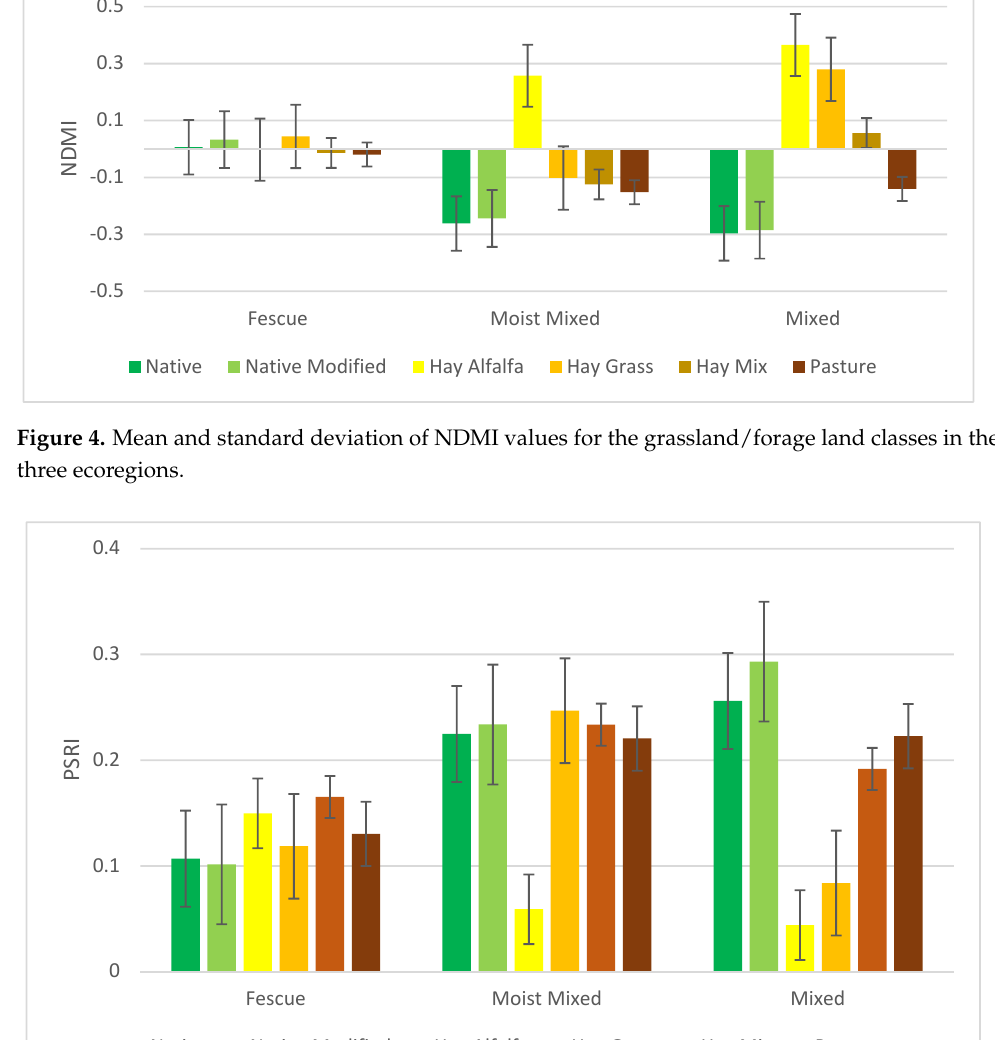
Figure 4. Mean and standard deviation of NDMI values for the grassland/forage land classes in the three ecoregions.